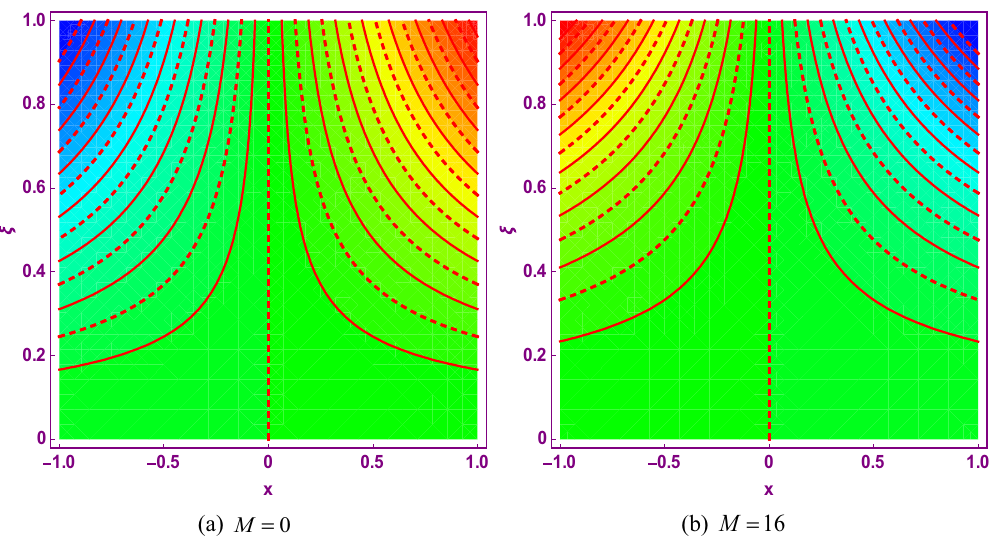
Figure 14. Streamlines patterns for M